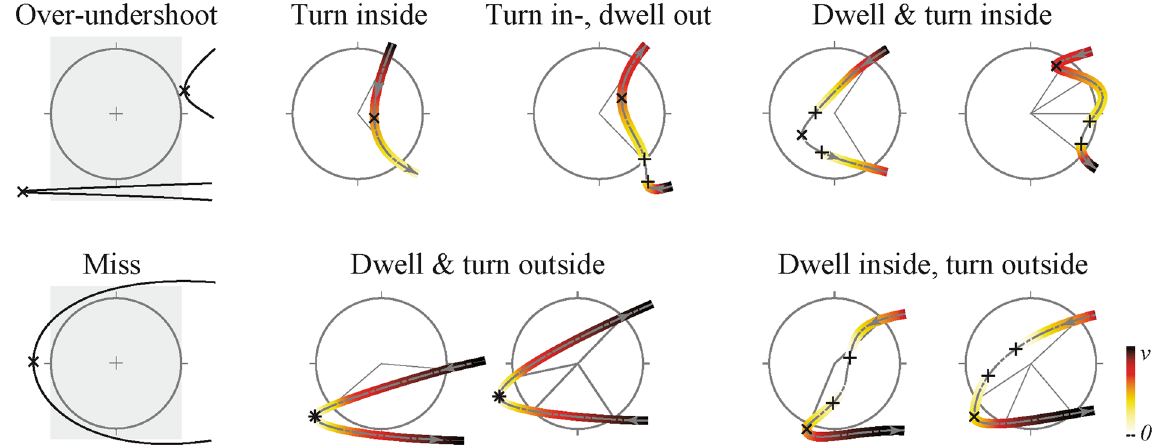
Figure 9. Subdivision of overshoots and undershoots and the characterization of dwell time based on the velocity profiles. The color-coding signifies the speed along the trajectory. The cross ( x ) indicates the turning point. The plus ( + ) indicates the movement onset and offset. The grey block for an over-undershoot and a miss represents the area that would have been included if only the horizontal position and its first derivative would have been taken into account, illustrating the possible errors that would have been falsely taken into